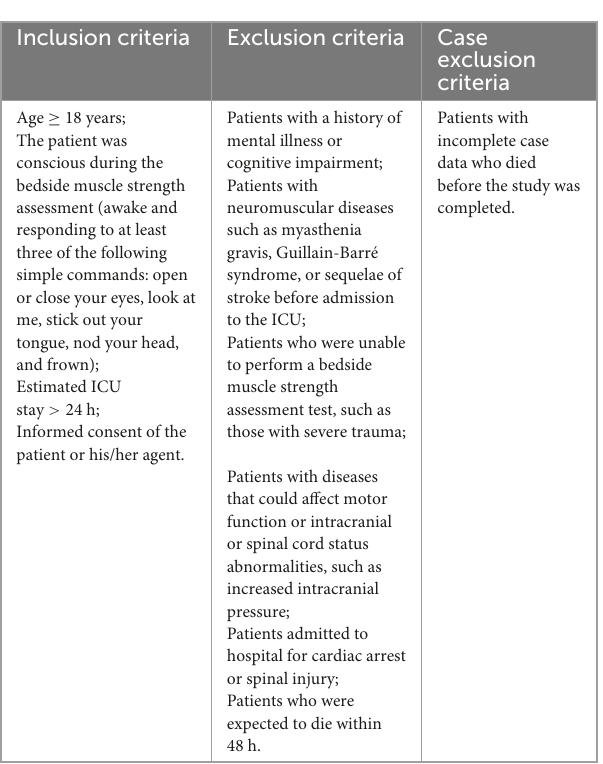
TABLE 2 Criteria for inclusion and exclusion of participants. Inclusion criteria Exclusion criteria Case